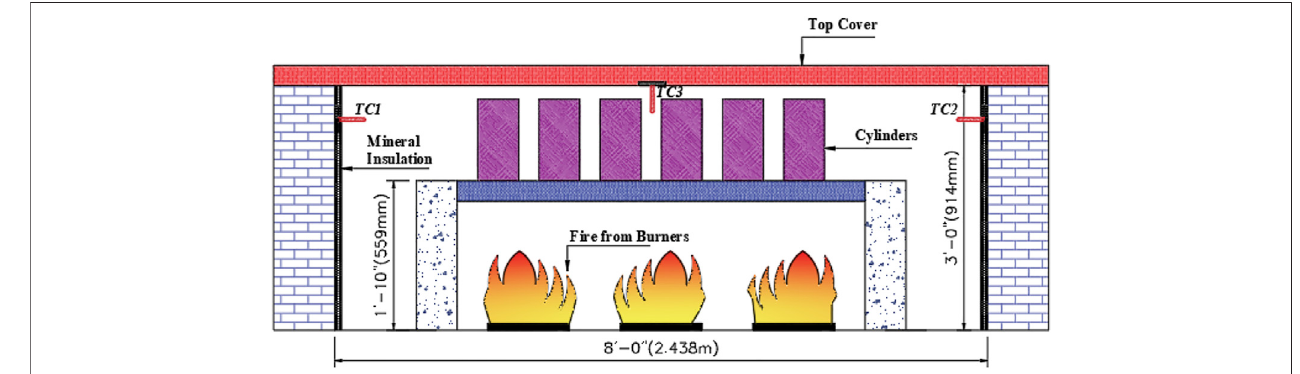
FIGURE 1 | Test setup for heating for specimens in the furnace.